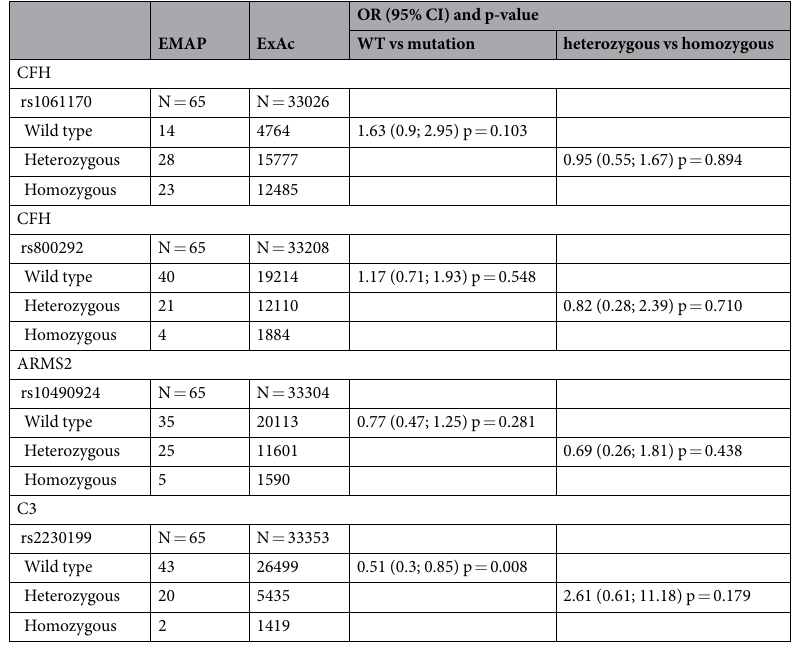
Table 3. Analysis of the five alleles of the alternative complement pathway associated with AMD noted in EMAP patients (n = 65) versus ExAc data non-Finnish European population). WT: Wild